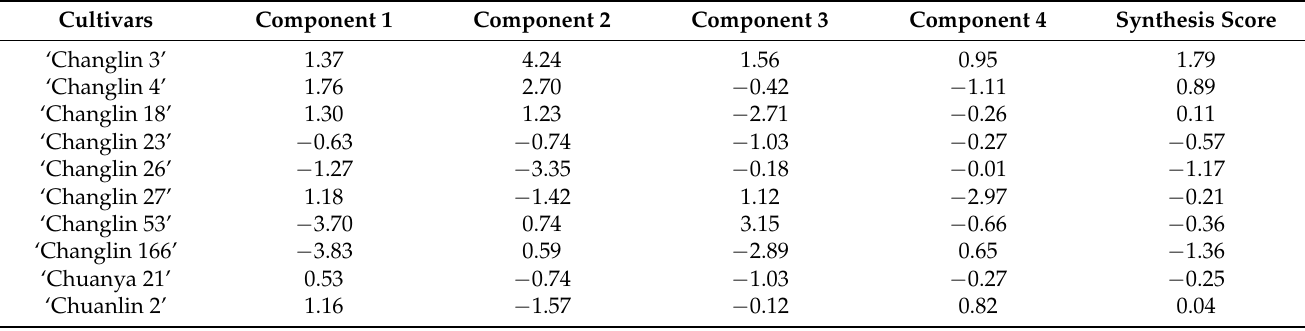
Figure 2. The score plot of oil samples. PC1, principal component 1; PC2, principal component 2; PC3, principal component 3; and PC4, principal component 4. Table 5. Principal components and synthesis score.